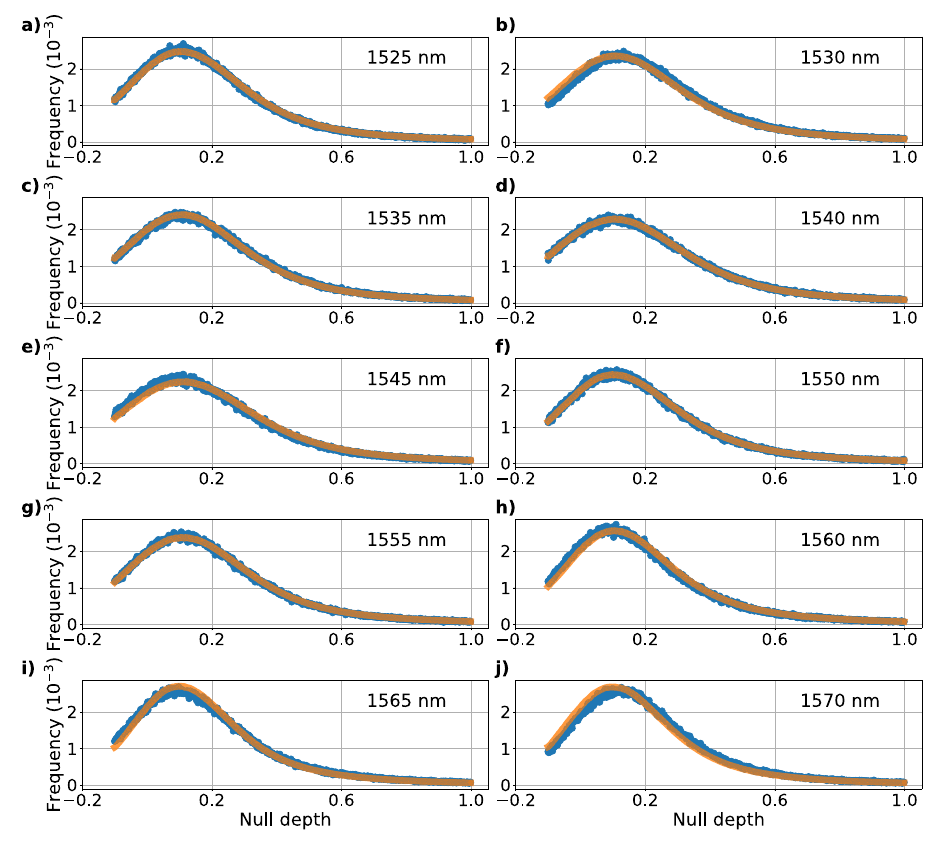
Fig. 7 Histograms of the measured null depth of base N1 computed over 10 dispersed spectral channels with the fi tted curves. Each subplot from ( a ) to ( j ) shows the histogram of the measured null depth of base N1 on α Boo (blue dots) and the fi tted model (orange curve), in each of the spectral channel spanning from 1525 to 1570 nm. The fi tted parameters are N obj,12 = 7.05 × 10 − 2 ± 1.86 × 10 − 4 , μ OPD = 302 ± 0.465 nm and σ OPD = 163 ± 0.163 nm for a reduced χ 2 of 2.51.